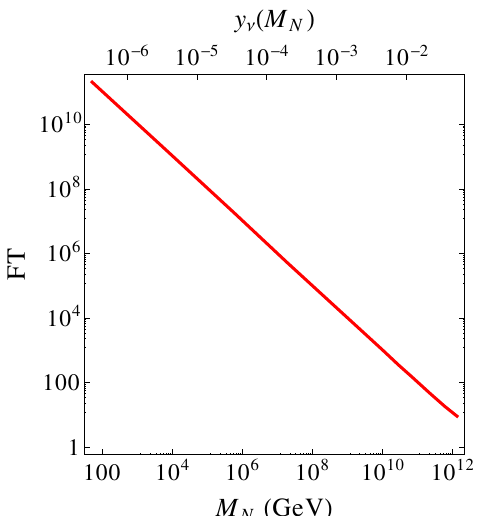
, the fine tuning (FT) of the parameter f Figure 2. For the case f y > f crit ν,tY different choices of the Majorana mass and neutrino Yukawa coupling in Type-I see-saw scenarios. this scenario y ∗ is real, IR-attractive, and not much smaller than g ∗ ν